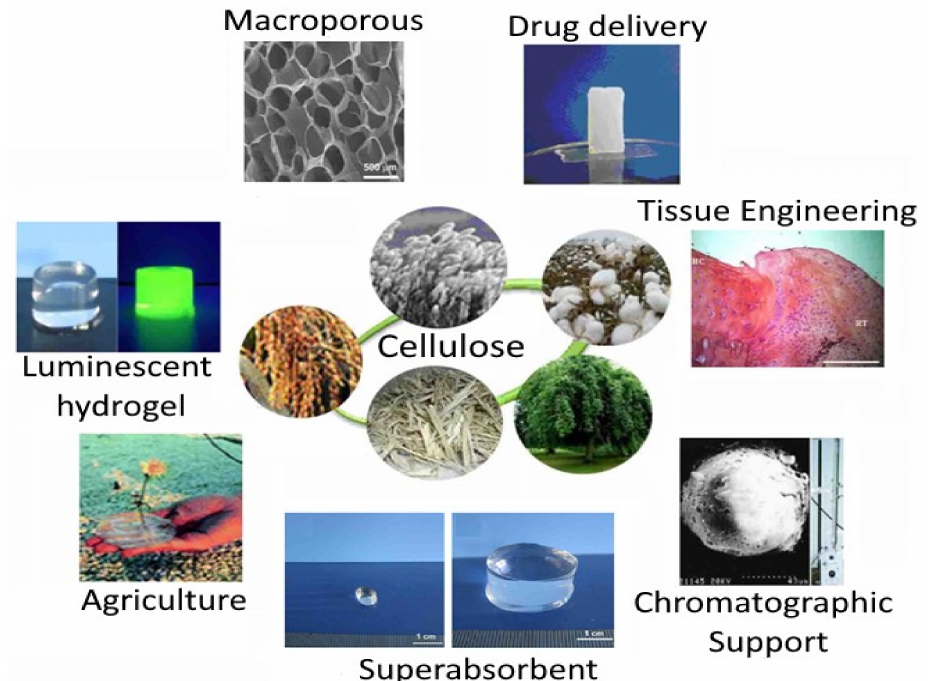
Figure 4. Applications of cellulose-based hydrogels (CBHs) in different fields. Figure 4 is adapted with permission (Copyright © 2010 Elsevier Ltd., Amsterdam, The Netherlands) from Chang and Zhang